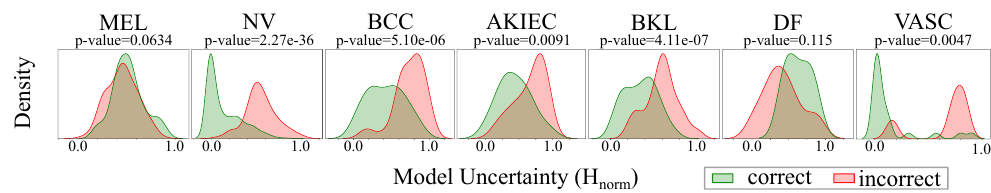
Figure 10. Distribution of normalized uncertainty values ( H norm ) for each lesion type, grouped as correct and incorrect predictions. p -values are for the Kruskal–Wallis test between the correct and incorrect distributions for the null hypothesis that the population median of the two distributions are equal.